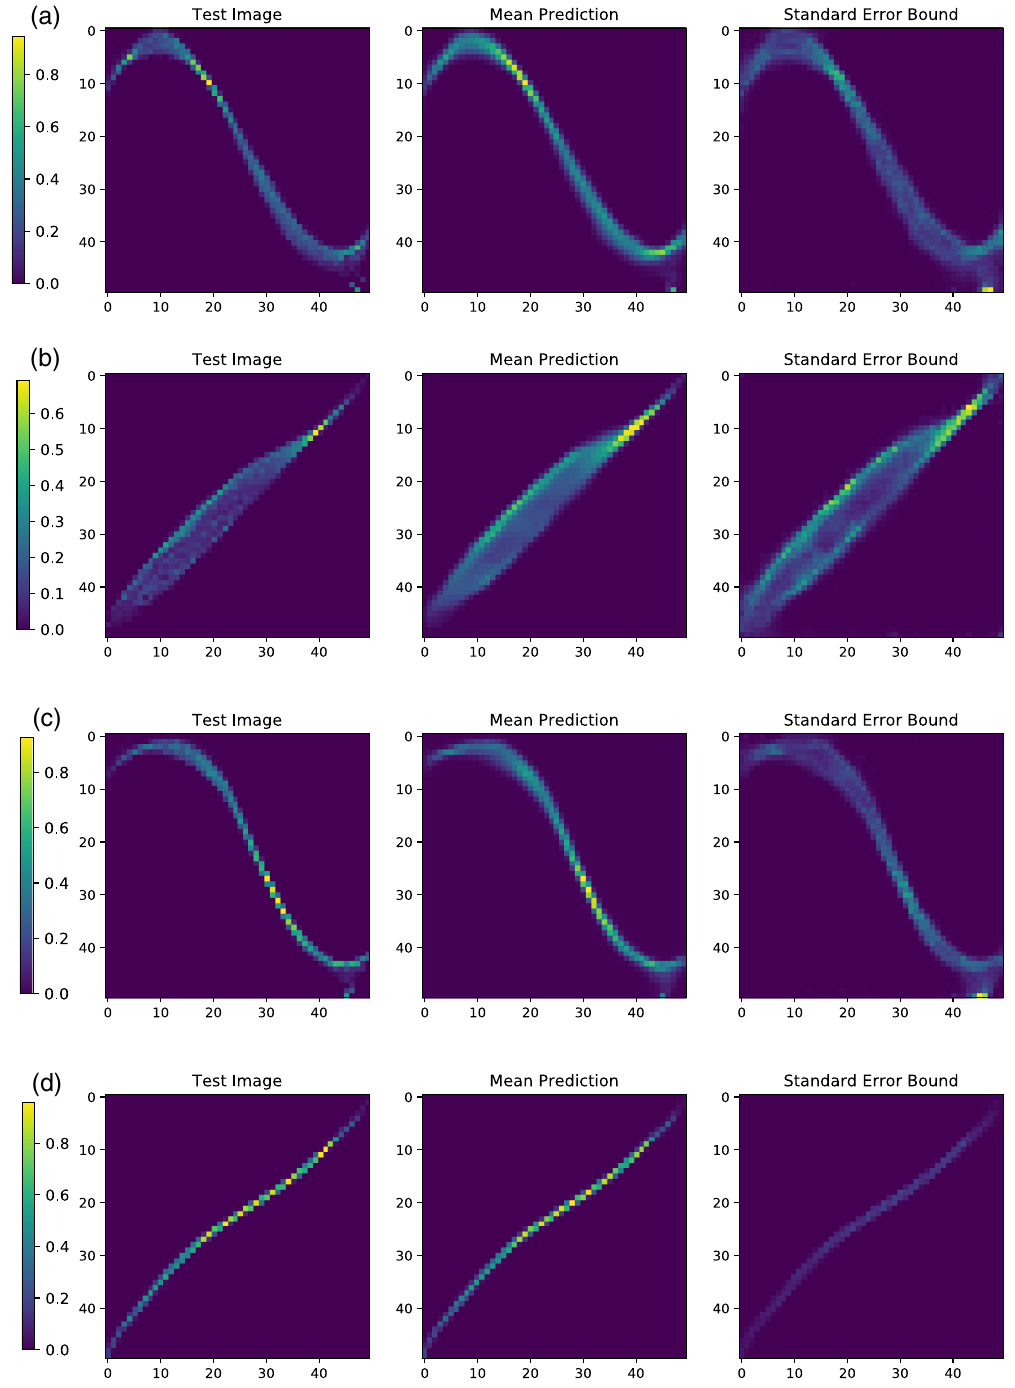
FIG. 12. Simulation test images, Bayesian neural network predictions and predicted standard error bounds for the LCLS-II injector longitudinal phase